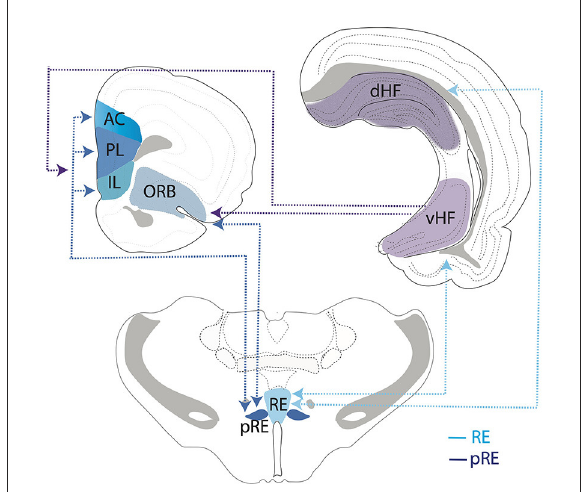
FIGURE4 Schematic representation depicting interconnections/circuitry between the nucleus reuniens (RE) and the peri-reuniens (pRE), the medial (mPFC) and orbital (ORB) prefrontal cortices and the hippocampus (HF). While both RE and pRE are interconnected with the mPFC, ORB and HF, there is differential weighting of connections such that the RE (or medial RE) is more heavily reciprocally connected with the dorsal (dHF) and ventral (vHF) hippocampus (light blue lines/arrows), whereas pRE is more strongly reciprocally connected with the mPFC and ORB cortices (dark blue lines/arrows). While the vHF sends projections to the mPFC/ORB (purple lines/arrows), there are essentially no return projections from the orbitomedial PFC cortex to the HF. Further, the dHF does not project directly to the mPFC/ORB. As such, RE/pRE is a key intermediary in this circuitry. Dashed lines and arrows represent direction